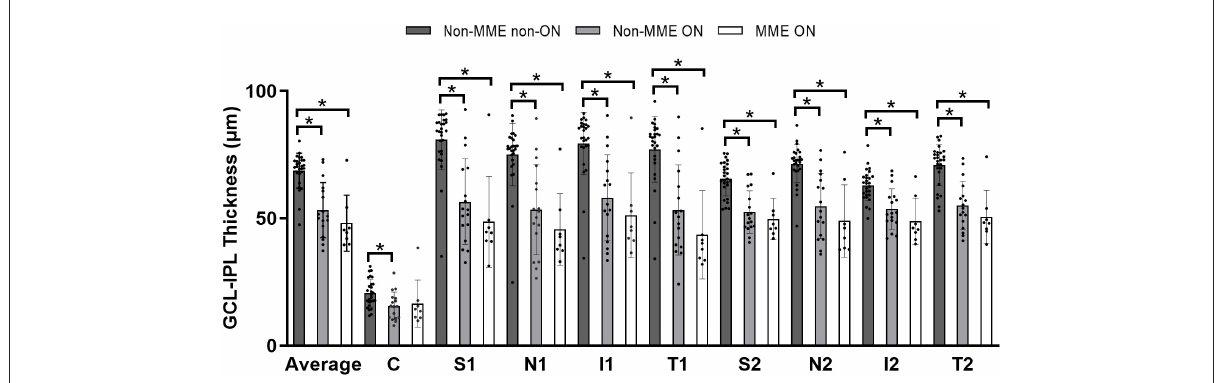
FIGURE5 Comparison of ganglion cell layer plus inner plexiform layer (GCL-IPL) thickness among three groups. * P < 0.05. GCL-IPL, ganglion cell layer plus inner plexiform layer; MME, microcystic macular edema; ON, optic neuritis; C, center; S, superior; N, nasal; I, inferior; T,